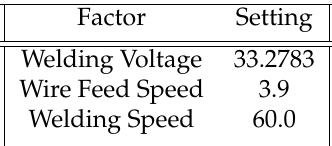
Table 10. Factor settings at